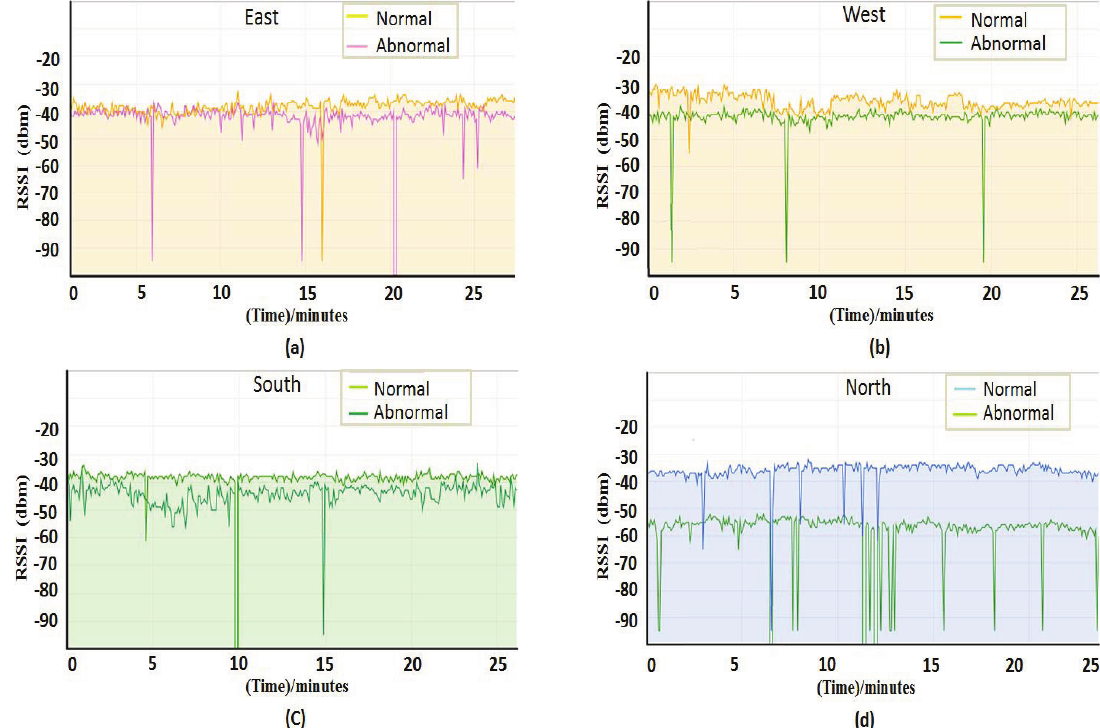
Figure 5. Environmental impact on RSSI. ( a ) RSSI values that are measured in the east. ( b ) RSSI values that are measured in the west. ( c ) RSSI values that are measured in the south. ( d ) RSSI values that are measured in the